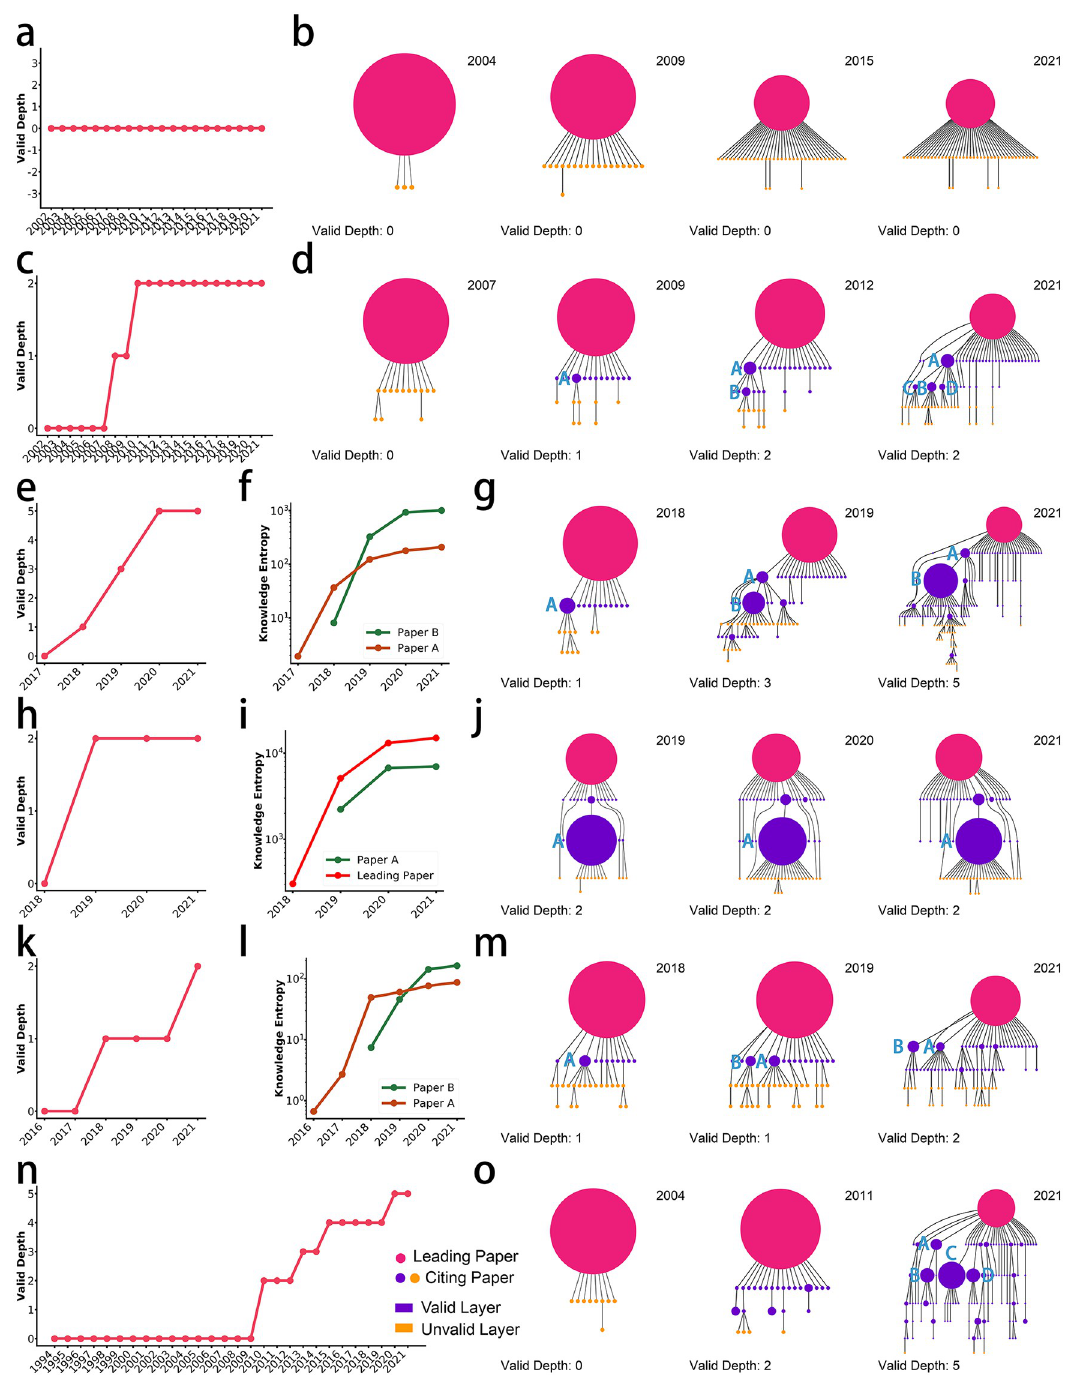
Fig 3. Six fixed evolution patterns of publication’s idea. (a,c,e,h,k,n) The evolution of VD of corresponding publications. (b,d,g,j, m,o) The evolution of idea trees of corresponding publications. All idea trees are pruned to ensure the visibility of the skeleton structure. All idea trees are visualized by the DOT algorithm [50]. Node size is rescaled in every idea tree and positively related to its KE. (f,i,l) The evolution of nodes’ KE in corresponding idea trees. These six patterns exist in a wide range of scientific fields and are not limited to geographic information system, ecology and climate change, computer vision, natural language processing, deep learning and geology.